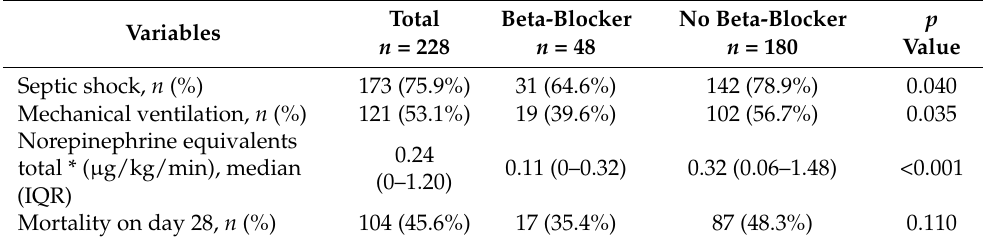
Table 2. Clinical outcomes of the study population.